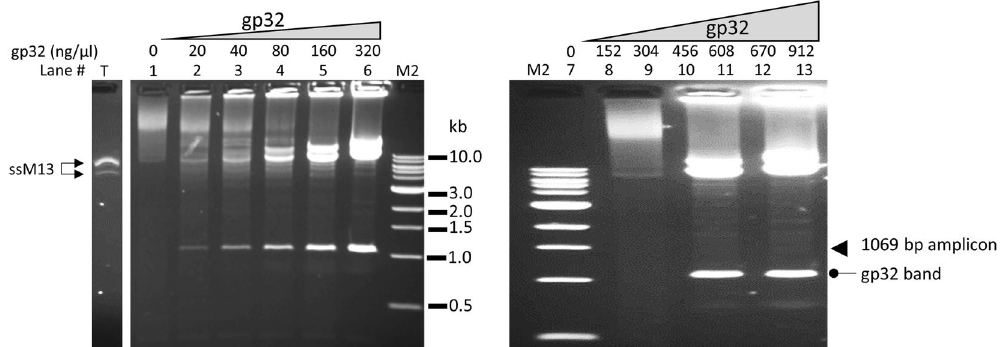
Figure 3. T4 gp32 protein-assisted isothermal amplification on circular ssDNA M13. Lane T was loaded with 0.1 μ g ss M13 DNA alone without any treatment. The amplification of 0.1 μ g of M13 ssDNA using primer # 25 with low range of gp32 (20–320 ng/ μ l) (left panel, lanes 2–6), or high range of gp32 (152–912 ng/ μ l) (right panel, lanes 8–13). Each panel has a lane with no gp32 (Lanes 1 and 7) as negative controls. The band of the single amplicon (1069 bp) is marked by an arrow in the right panel. M2 is 1 kb ladder DNA